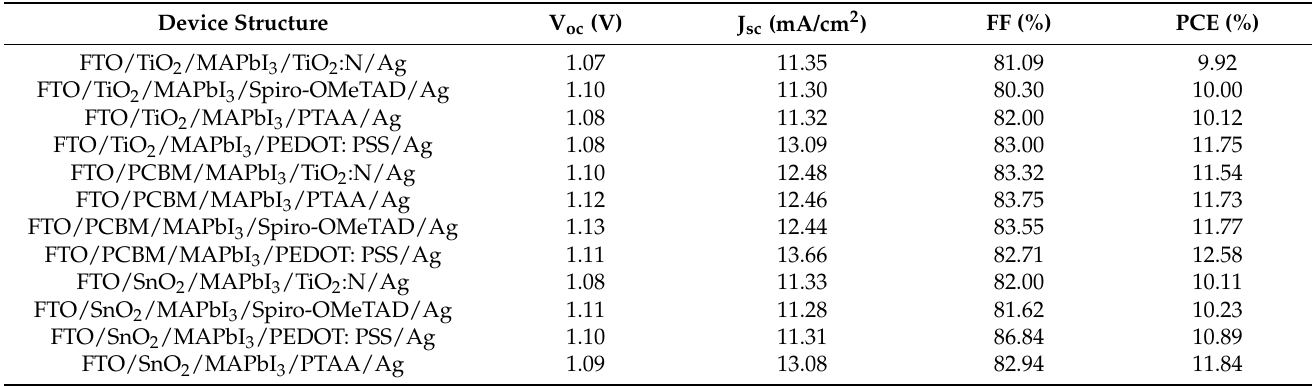
Table 2. Electrical parametric output attained from the simulation